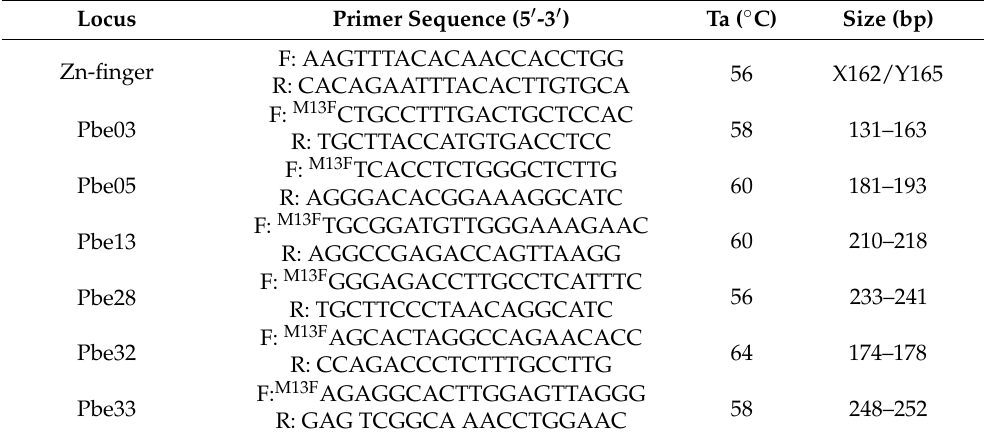
Table 1. Primer pairs for amplifying the sex chromosomes and microsatellites of the leopard